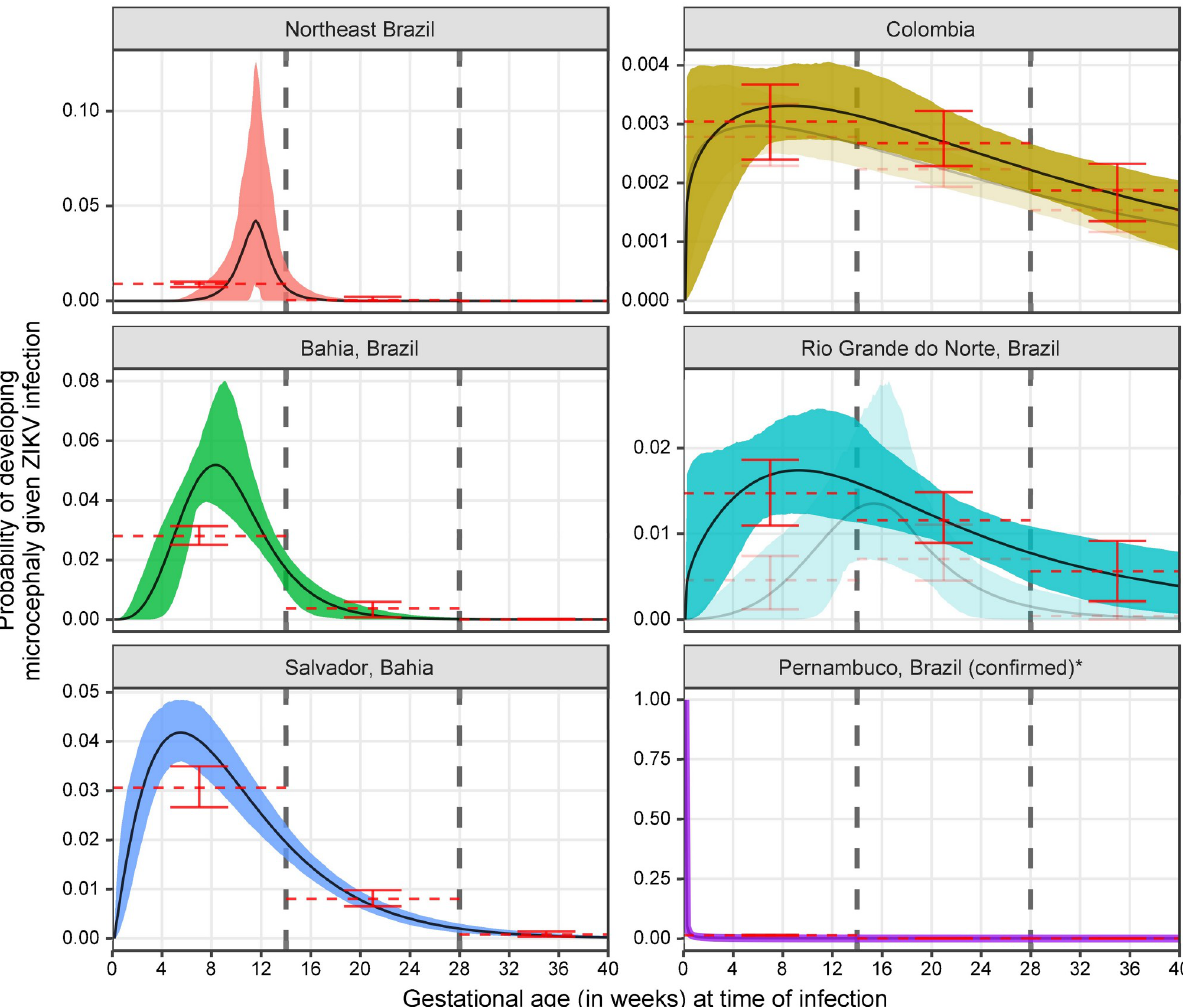
Fig 4. Estimates of the microcephaly risk profile fit to different data sets. Parameter estimates corresponding to these risk profiles are provided in S4 Table. Note different y-axis scales. Shaded regions show 95% credible intervals, black lines show posterior means. Vertical dashed lines show boundaries of the first, second and third trimester. Horizontal red dashed lines show the mean estimate for the mean model-derived risk (ie. average of the model suggested risk for that trimester) during each trimester and red bars show 95% credible intervals. Data sets were as follows (left-right). A: Notified ZIKV infections in pregnant women and confirmed microcephaly incidence data from the entirety of Northeast Brazil combined. [42] B: Notified ZIKV infection and microcephaly incidence data from Colombia (confirmed ZIKV faded). [43] C: Notified ZIKV infection and microcephaly incidence from Bahia, Brazil state-level reports. [44] D: Notified ZIKV infection and microcephaly incidence from Rio Grande do Norte, Brazil state-level reports (confirmed microcephaly faded). [45, 46] E: Notified AEI and microcephaly incidence from Salvador, Bahia, Brazil. [30] F: Confirmed microcephaly incidence from Pernambuco, Brazil state-level reports. [47]. Note that the model is unable to explain the observed data with a biologically interpretable risk profile, suggesting substantial bias in the